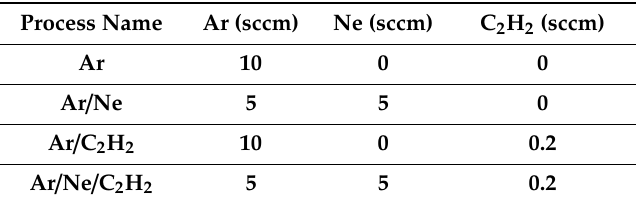
Table 1. Overview of the four deposition atmosphere mixtures used in this work, the pulse temporal characteristics and the peak current were kept